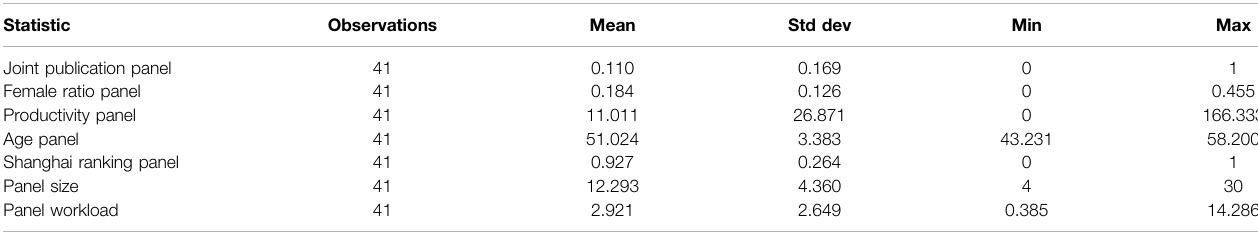
TABLE 5 | Descriptive Statistics of Expert Panel [41 panel groups].